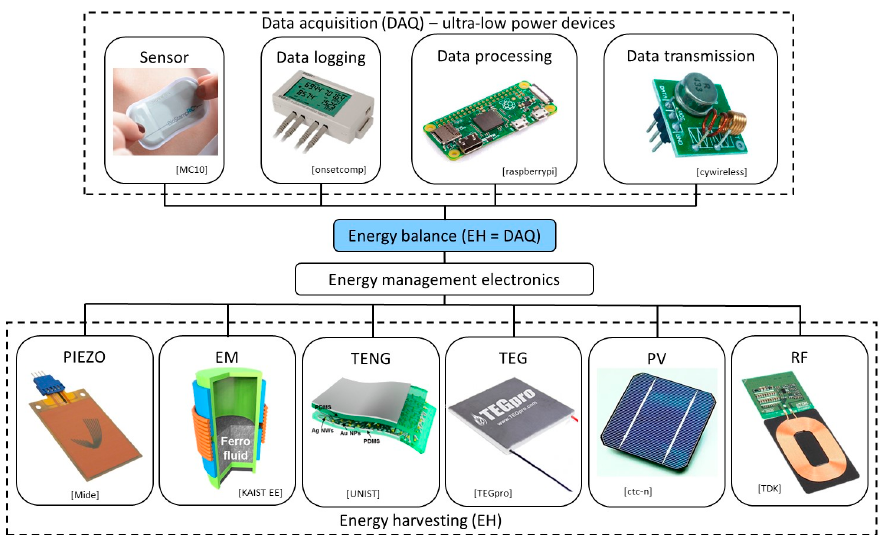
Figure 2. EH principle of powering autonomous sensor networks with the respective data elaboration and transmission modules.